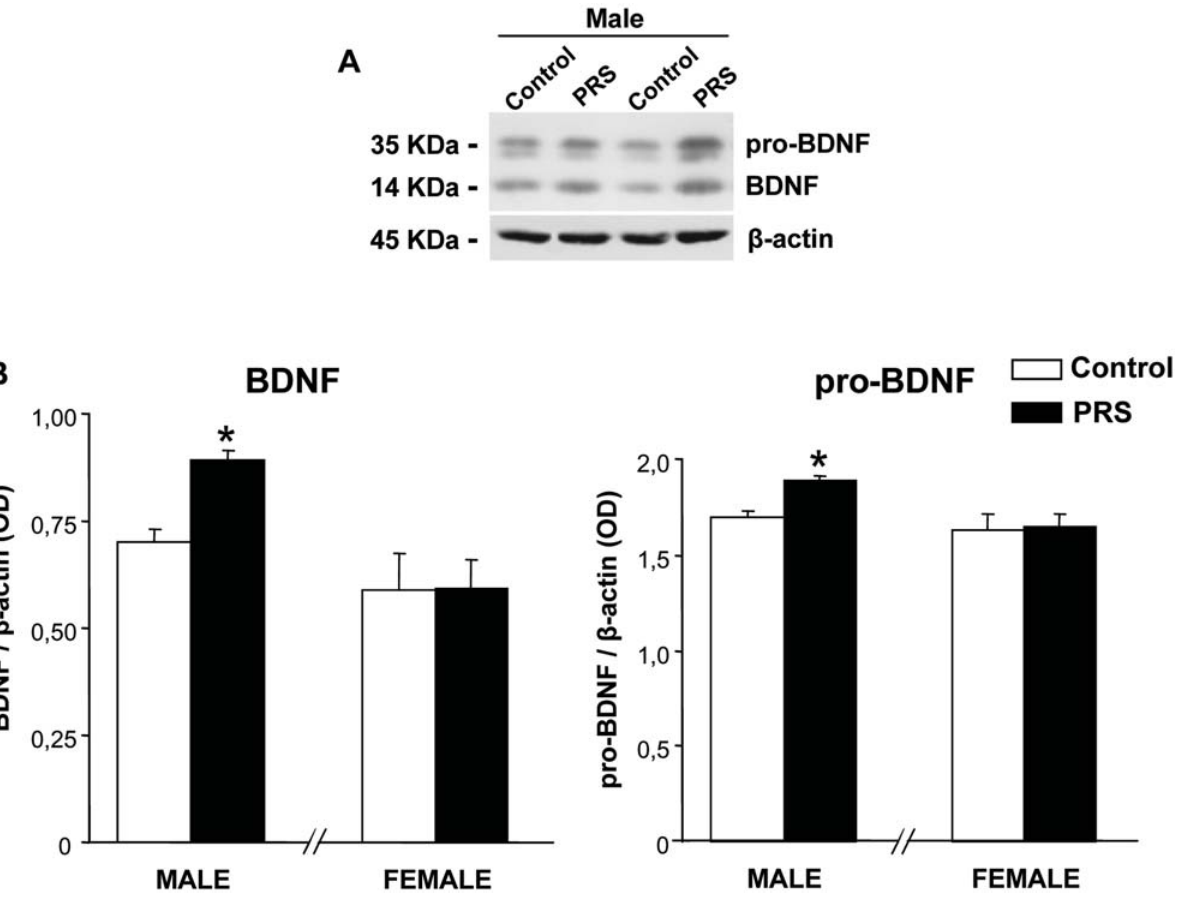
Figure 4. PRS enhances hippocampal BDNF levels in male rats. (A) Immunoblot analysis showed a 14 kDa band which corresponds to the mature form of BDNF, and a higher molecular weight band (about 35 kDa), which may correspond to its precursor, pro-BDNF. (B) PRS increased the steady-state levels of both BDNF and pro-BDNF in male rats (* p , 0.05, ANOVA: F (1,12) =29.68, F (1,12) =27.09, respectively,), but had no effect in female rats. Male and female hippocampi were processed separately. Results are expressed as the ratio of the optical density (OD) of the pro-BDNF or BDNF band and the b -actin band. Values are expressed as means 6 S.E.M. (n=7 rats per group). (Fig. 5A,B). PRS had no effect on the expression of mGlu1a or mGlu5 receptors in female rats (Fig. 5A,B). Interestingly, PRS reduced mGlu 2/3 receptor expression in the hippocampus of both male and female rats (Fig. 5C).